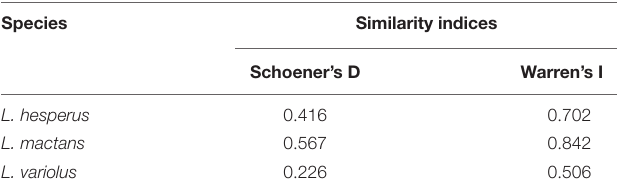
TABLE 4 | Similarity indices, Schoener’s D and Warren’s I, ranging from 0 (no overlap) to 1 (complete overlap) of species geographic overlap with L. geometricus